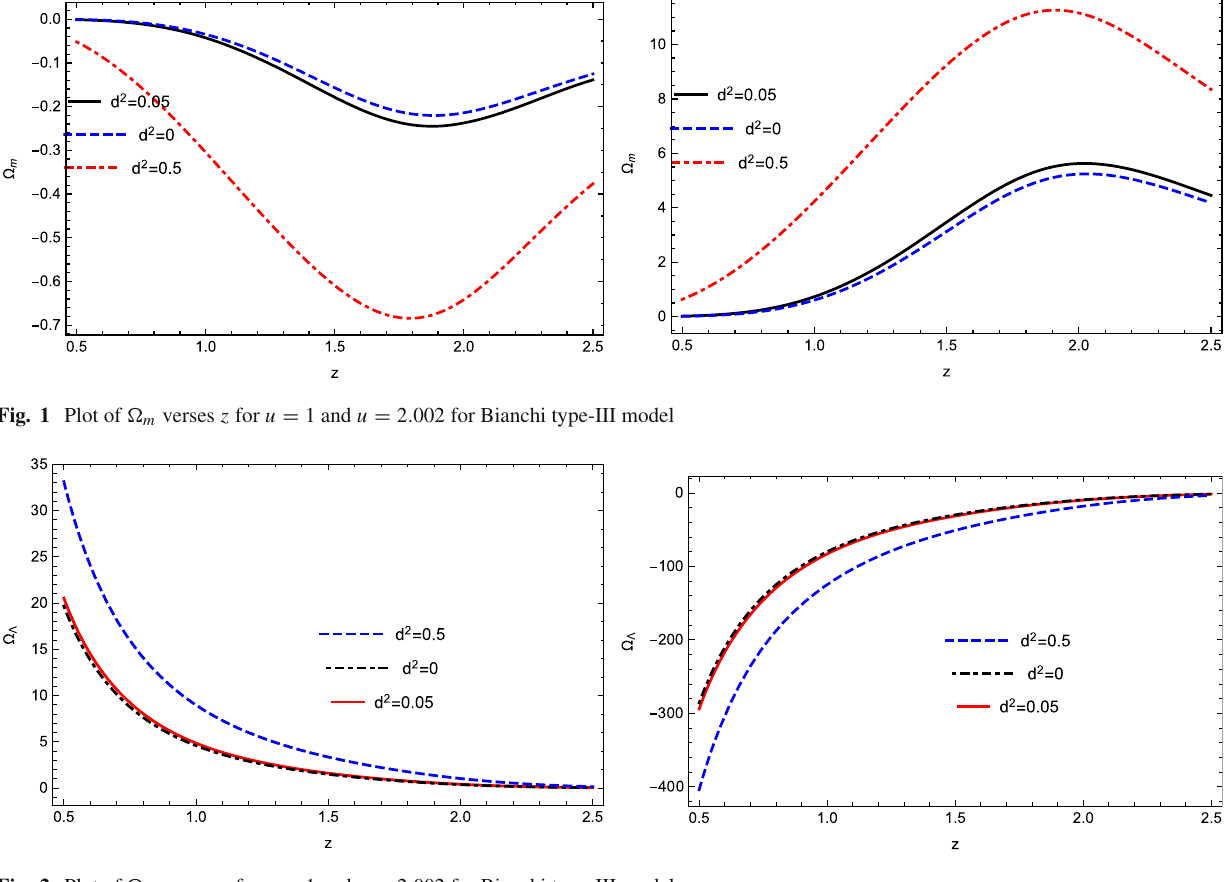
Fig. 2 Plot of (cid:9) (cid:2) verses z for u = 1 and u = 2 . 002 for Bianchi type-III model